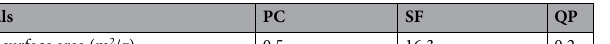
Materials PC SF QP Specific surface area (m 2 Table 2. Specific surface of materials obtained by the Blaine (Portland cement) and BET (silica fume and quartz powder) methods.